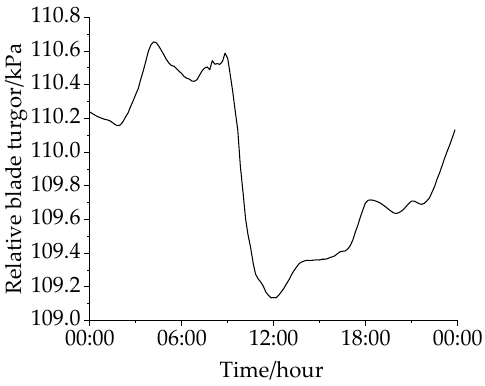
Figure 12. Turret pressure curve under preliminary water stress.